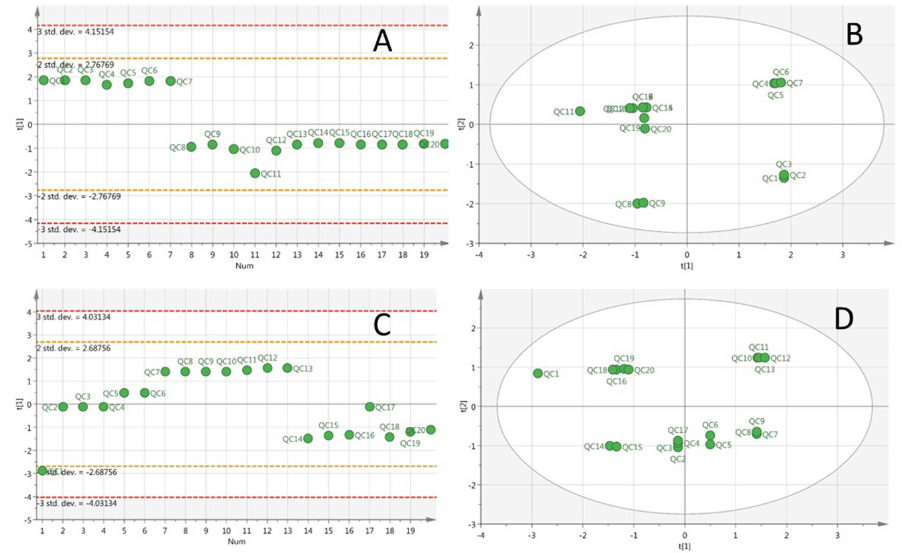
Figure 2. PCA of QC samples. Line plot (X-axis: run order; Y-axis: standard deviation) in positive ion mode ( A ); score plot (cycle represents 95% confidence interval) in positive ion mode ( B ); line plot in negative ion mode ( C ); and score plot in negative ion mode ( D ).